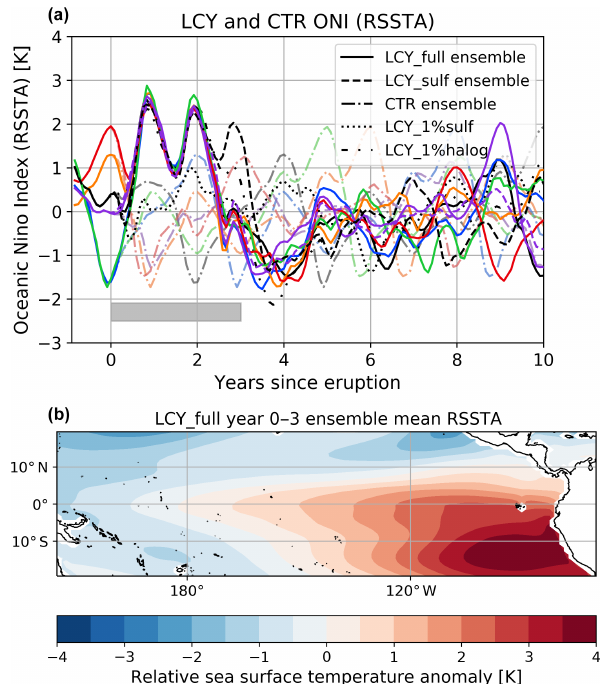
Figure 6. ENSO response to the simulated Los Chocoyos eruption and control run (CTR). (a) Ocean Niño Index (ONI) time series based on relative sea surface temperature anomalies (RSSTA) for the LCY_full ensemble, LCY_sulf and LCY_1%sulf (see legend) in full color. The corresponding model years of the CTR without an eruption (see branch years in Table 1) are indicated with pale colors. (b) Averaged RSSTA over the equatorial Pacific for the first 3 post-eruption years as indicated by the gray box in (a)